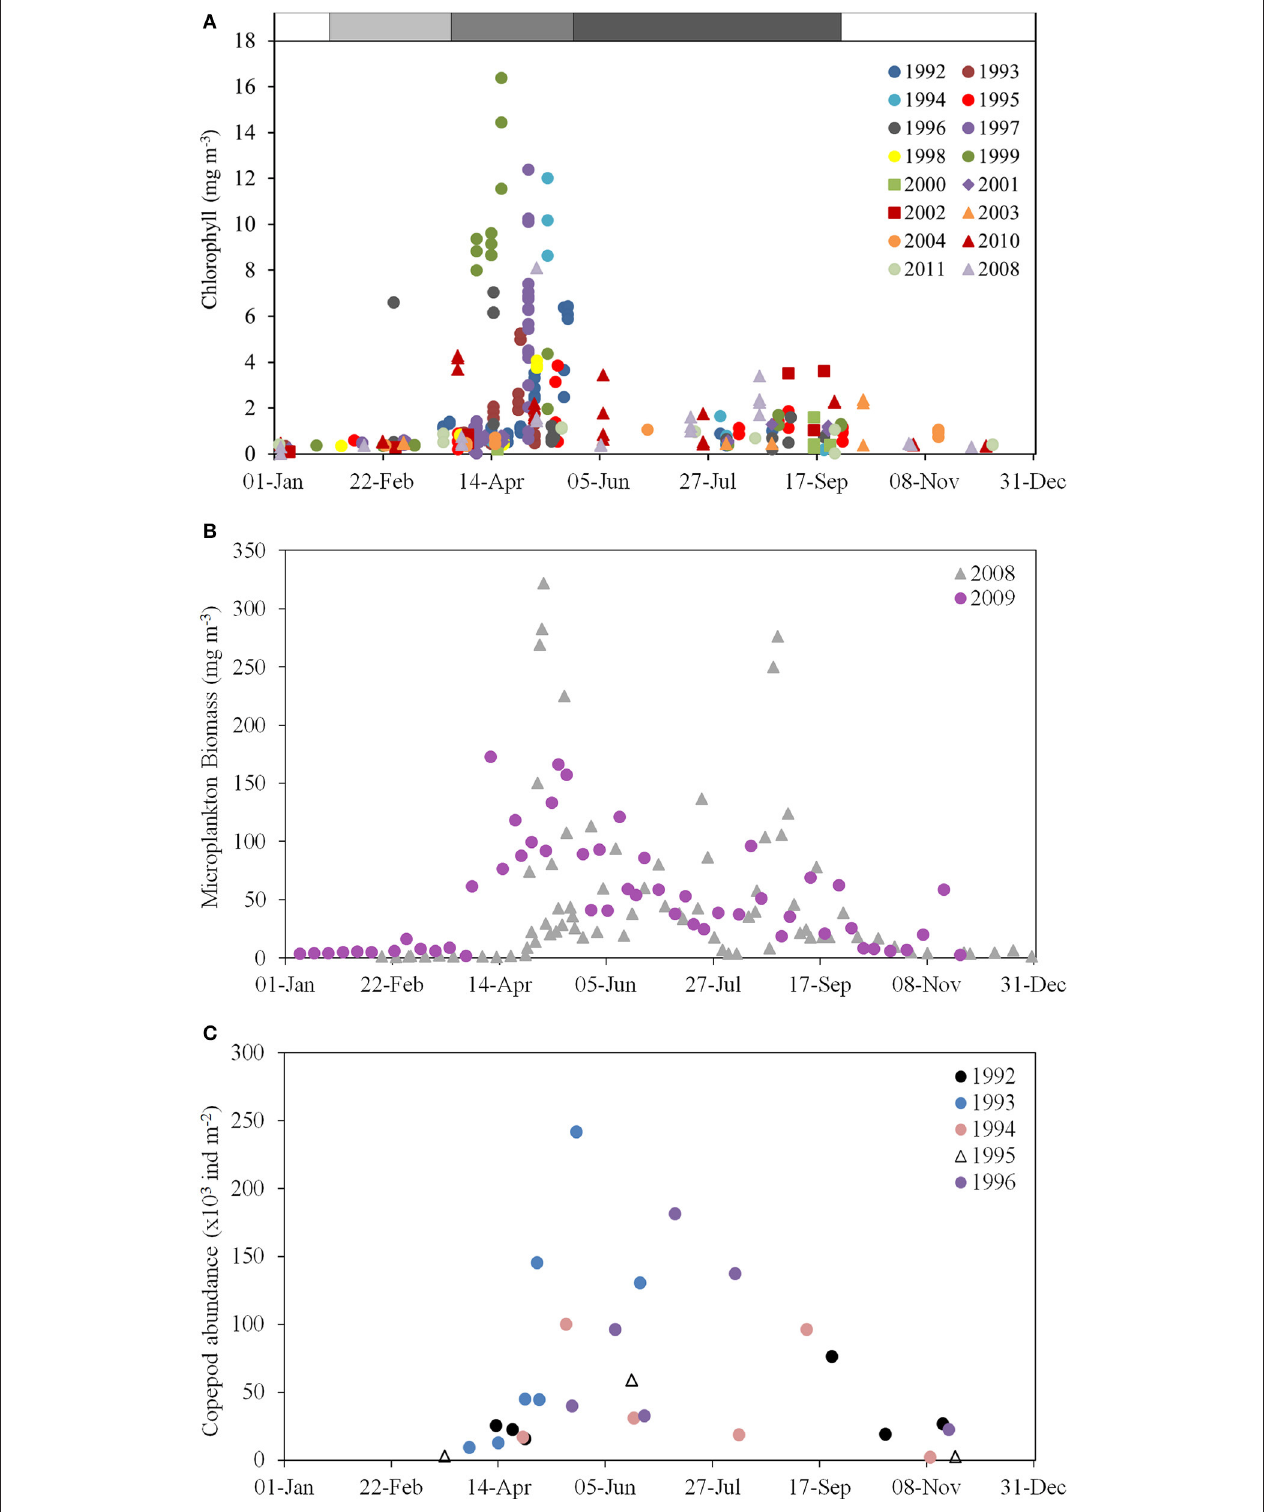
FIGURE 6 | Chlorophyll, microplankton and zooplankton climatologies for the WIS. (A) Chlorophyll concentration (mg m − 3 ) in ship-sampled water at station 38A, 1992–2011 (AFBI, unpublished); (B) Microplankton (micro-algal and protozoan) biomass (mg m − 3 ) at station 38A in 2008–2009 (Scherer, 2012); (C) Column copepod abundance (1000 individuals per m − 3 ) estimated by vertical tow-net hauls in 1992–1996 (Gowen et al., 1997).